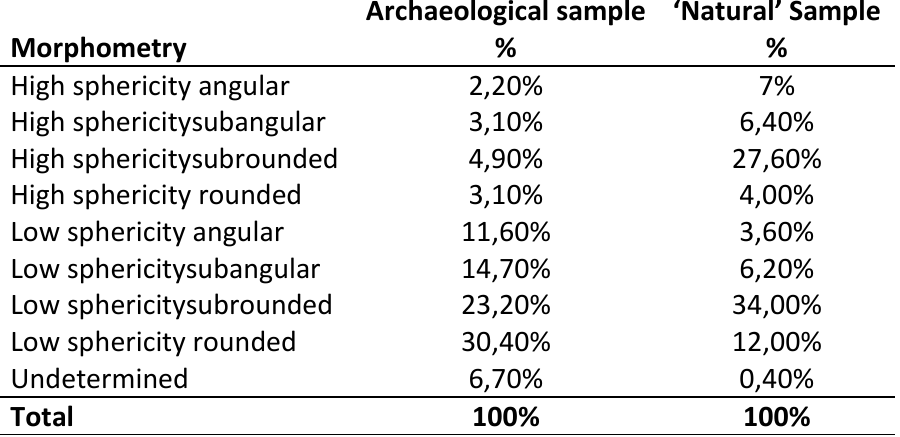
Table 7. Distribution of the observed morphometries in the archaeological sample in comparison with the ‘natural’ sample.